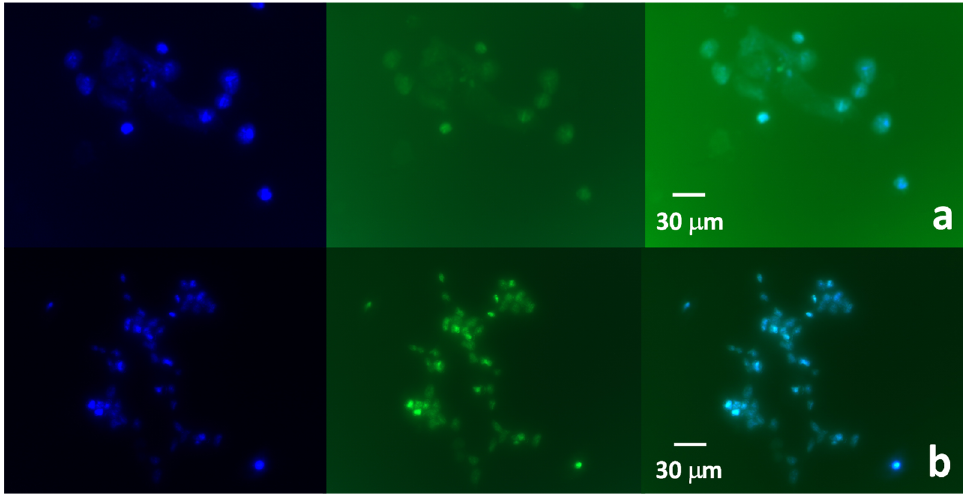
Figure 7. Images of the HEK-293 cells treated with ( a ) N-CQDs-40 min and ( b ) N-CQDs-15 h. Magnification: 40 × . In each layer, the blue fluorescence of the nuclei stained with DAPI is reported, followed by the green fluorescence due to the N-CQDs and the overlap of the two.